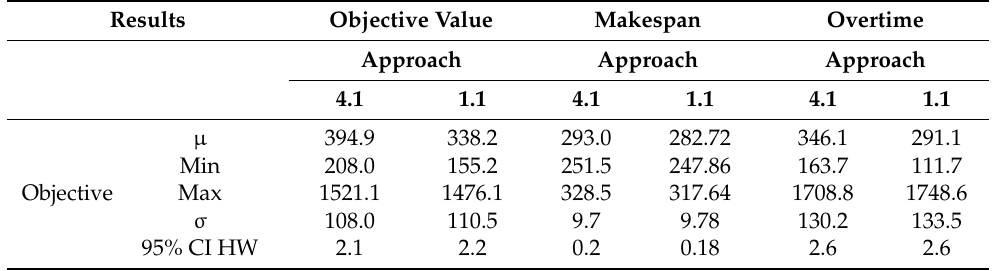
Table 11. The gap between the solution of the SDSMO model with clustering and the baseline schedules. Results Objective Value Makespan